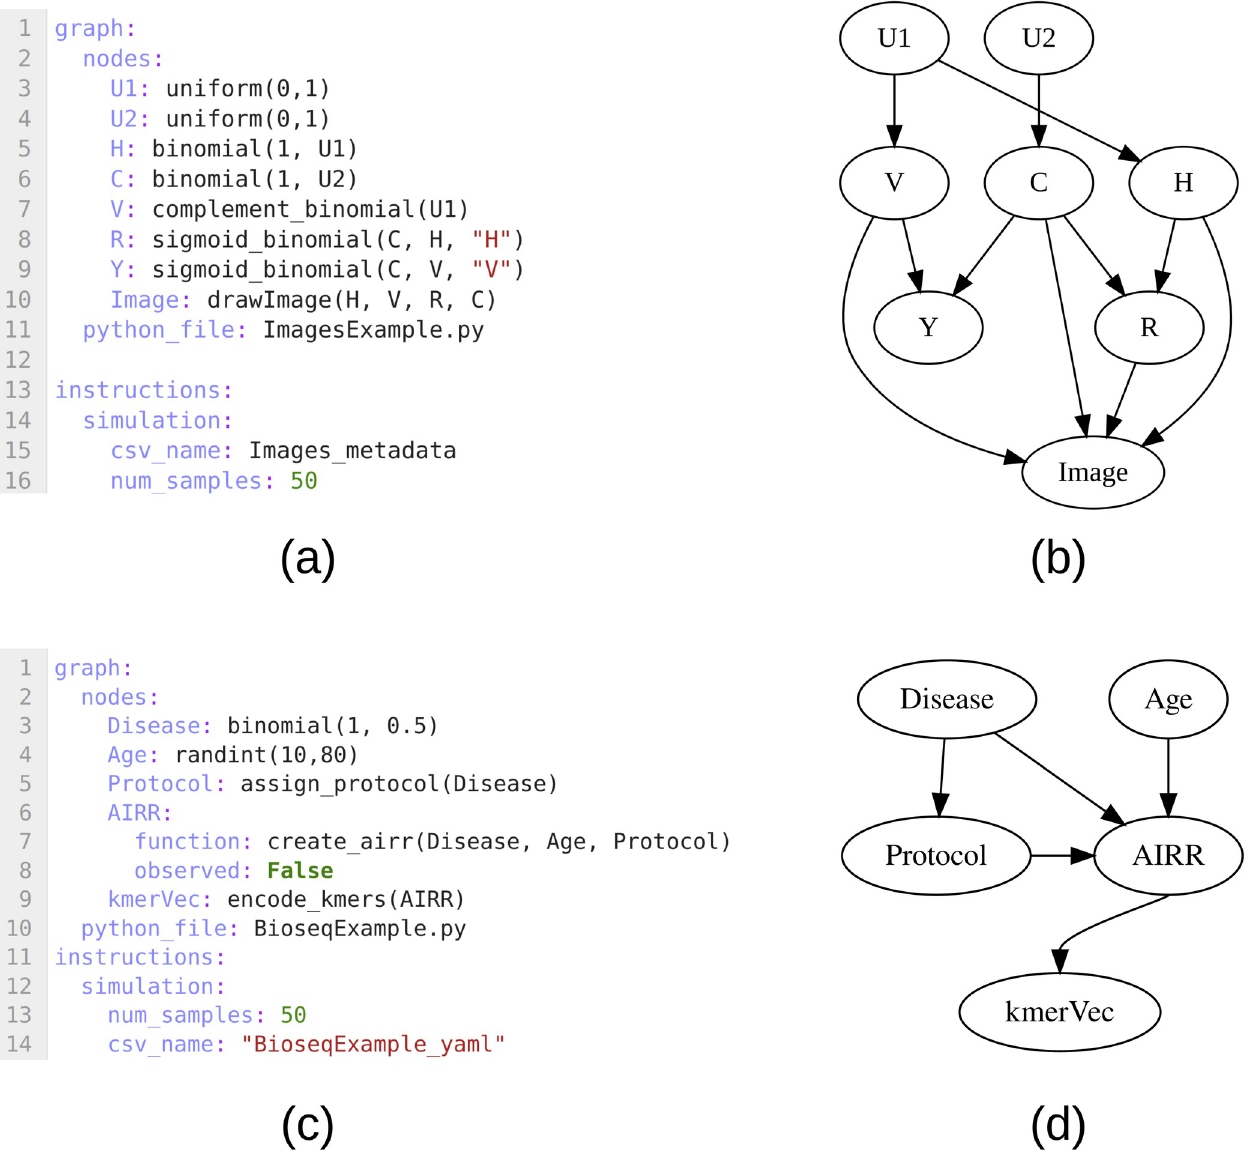
Fig 2. (a-b) The YAML specification and corresponding DAG for the image simulation use case, (c-d) The YAML specification and corresponding DAG for the biosequence simulation use case.